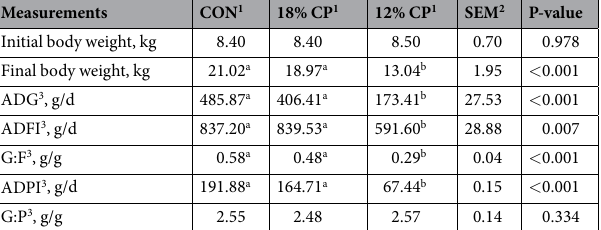
fecal microbiota. Based on the rarefaction curve analysis, all samples analyzed reached a stable plateau at 40,000 reads and 1,000 operational taxonomic units (OTU’s) (Supplementary Fig. S3), which suggests the sequencing depth was sufficient to capture the species richness of the samples. Principle coordinates analysis (PCoA) showed a significant separation and clustering when 12% CP vs. 18% CP (PERMANOVA analysis P values = 0.02; Fig. 3C) and 12% CP vs. 18% CP vs. CON (PERMANOVA analysis P values = 0.04; Fig. 3D) were considered confirming the differences in gut microbiota composition among these dietary groups. No clear clustering was seen for fecal bacterial composition of CON vs. 12% CP (PERMANOVA analysis P values = 0.07; Fig. 3B) and CON vs. 18% CP groups (PERMANOVA analysis P values = 0.38; Fig. 3A). Overall, the three main phyla present in all three dietary treatments were Firmicutes, Bacteroidetes and Proteobacteria (Fig. 4A). The most abundant community at genus level for all three dietary treatments was Prevotella (Fig. 4B). At family level, Prevotellaceae, Veillonellaceae, Ruminococcaceae, and Lachnospiraceae were the most abundant communities across all diets (Fig. 4B). Linear discriminant analysis (LDA) with effect size measurements (LEfSe) was used to identify organisms that are different among dietary conditions and are also of statistical and biological significance. Compared to CON, 18% CP group had higher proportions of Succinivibrionaceae_UCG_001 (LDA [log 10 ] score > 2.0; Fig. 5A and Supplementary Fig. S4). Pigs fed with CON diet had higher proportions of Prevotella_9 and Prevotella_1 compared to those fed 12% CP diet (Fig. 5B and Supplementary Fig. S5). However, the feces of pigs fed 12% CP was enriched in Succinvibrio, Christensenedilaceae_R_7_group , Parabacteroides, Algiphilus and Algoriphagus com- pared to CON (Fig. 5B and Supplementary Fig. S5). Pigs fed with 12% CP diet had higher proportions of Marivita ,